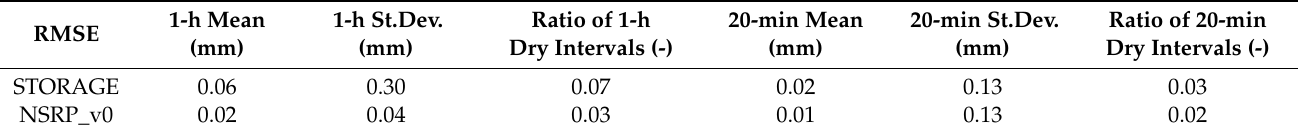
Table 4. Montalto Uffugo rain gauge: evaluation of STORAGE and NSRP_v0 performances. RMSE values related to the mean, standard deviation and percentage of dry intervals for the continuous 20-min and 1-h series. 1-h Mean 1-h St.Dev. Ratio of 1-h RMSE (mm) (mm) Dry Intervals (-) STORAGE